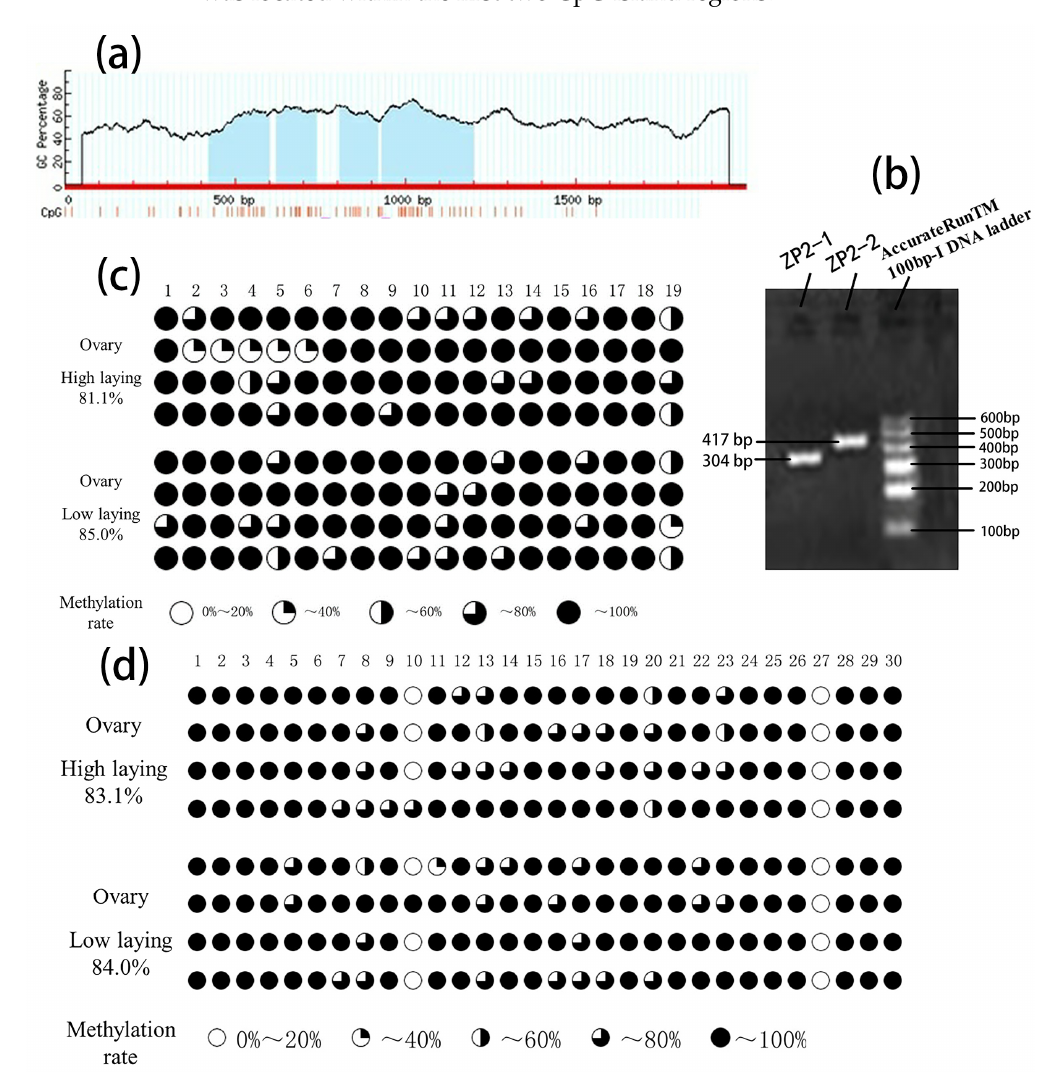
Figure 3. Prediction of CpG islands, examination of amplification products, and detection of methylation levels of different fragments in ovarian tissue. ( a ). Prediction of CpG islands. The four light blue regions are the predicted CpG islands in the promoter region of the ZP2 gene. The position of the horizontal coordinate “0” is the − 2000 position of the sequence; similarly, the position of the coordinate “500 bp” refers to the − 1500 position of the sequence, the position of the coordinate “1000 bp” refers to the − 1000 position of the sequence, and the position of the coordinate “1500 bp” refers to the − 500 position of the sequence. ( b ). Agarose gel electrophoresis of amplification products of the ZP2 gene using methylation primers. ( c ) . Methylation level of ZP2-1 fragment in the ovary. ( d ) . Methylation level of ZP2-2 fragment in the ovarian. Blank circles represent 0% ~ 20% degree of methylation, a quarter of black circles represent 20% ~ 40% degree of methylation, half of the black circles represent 40% ~ 60% degree of methylation, three-quarters of black circles represent 60% ~ 80% degree of methylation, all black circles represent 80% ~ 100% degree of methylation. Table 5. The methylation level of amplified fragments. Fragment